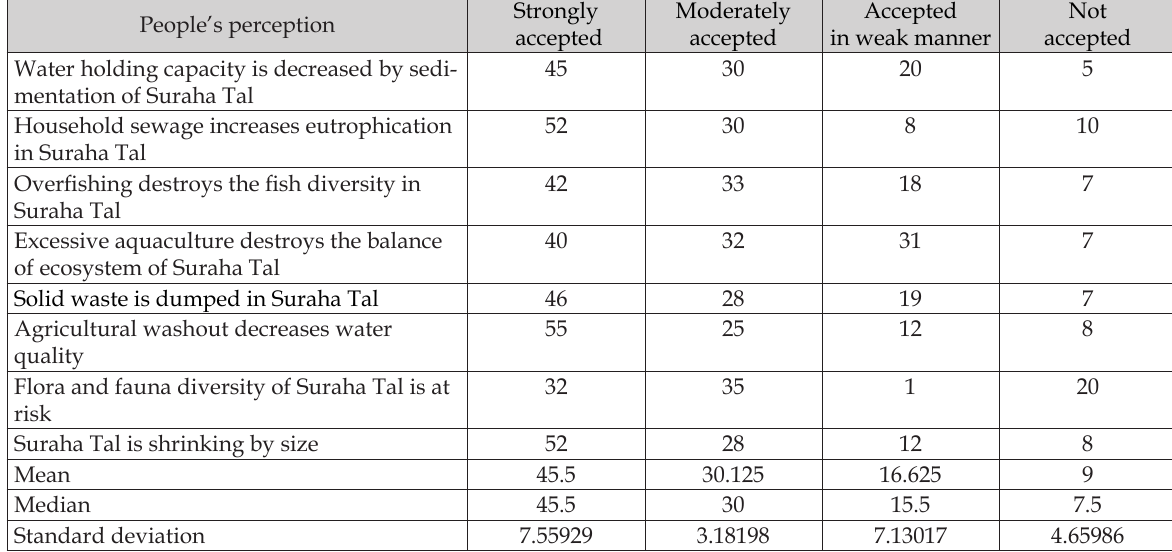
Table 6. Major threats of Suraha Tal Wetland.